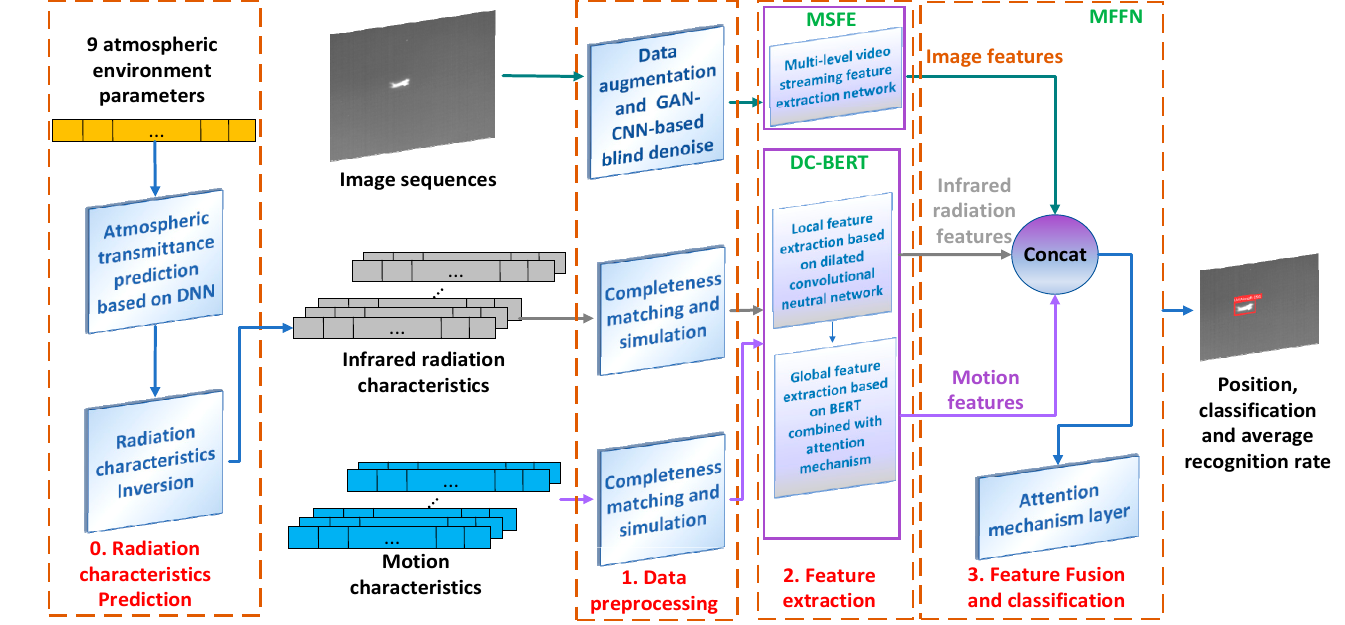
Figure 1. Overall flow chart of the infrared small-target detection method we proposed. This framework consists of a radiation characteristics prediction network, a data preprocessing network, a feature extraction network, and a feature fusion and classification network. The detection result contains the classification and localization of the targets.